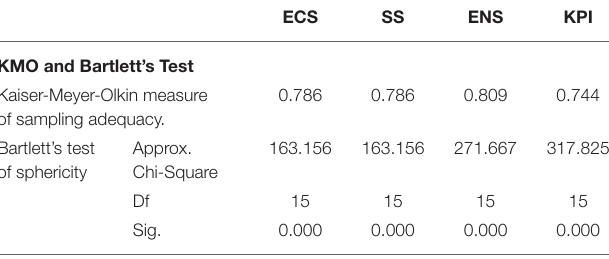
TABLE 4 | KMO and Bartlett’s Test statistic. KMO and Bartlett’s Test Kaiser-Meyer-Olkin measure of sampling adequacy.